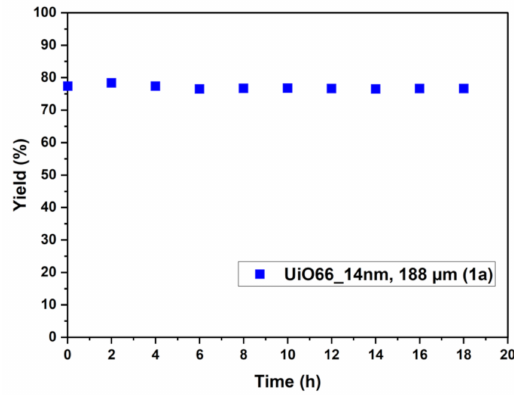
Figure 3. Stability of reaction yield for reference case of reactor 1a tested for 18 h at liquid flow rate of 0.5 mL / min and 20 ◦